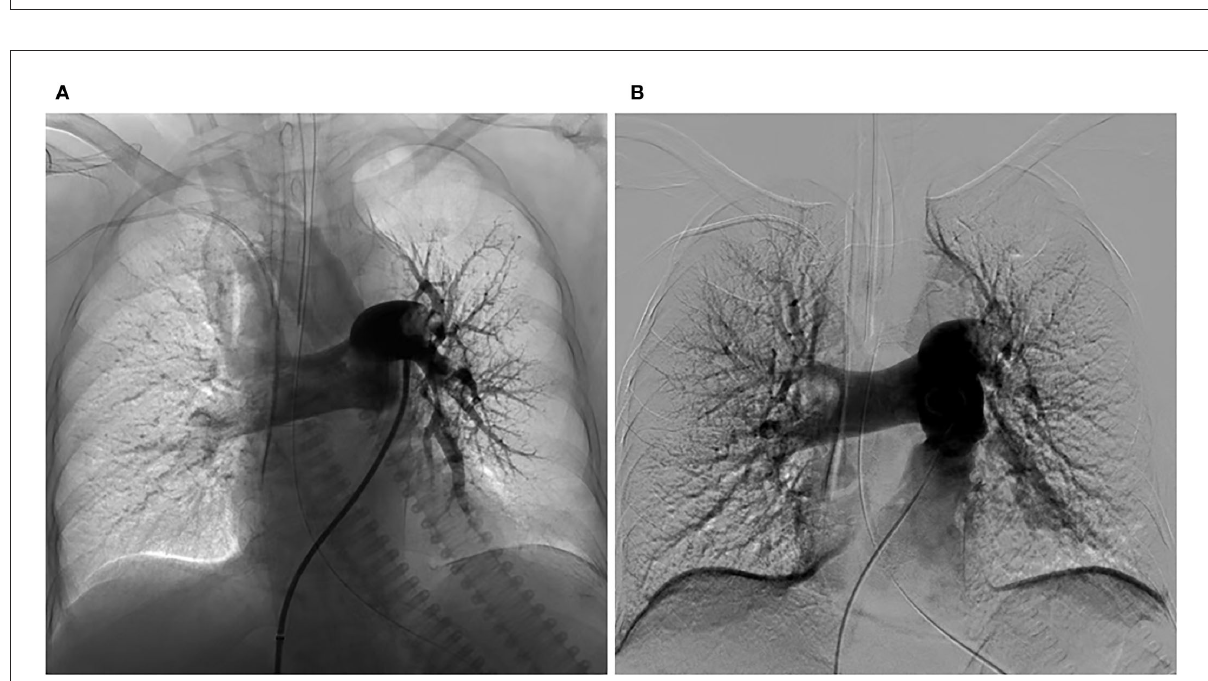
FIGURE2 Changes in the pulmonary arteriography before and after CDT. (A) Pulmonary angiogram showing a mass filling defect in the distal end of bilateral pulmonary artery trunks and branches of the left lower lobes and poor perfusion before CDT. (B) Pulmonary angiogram showing the reduced defect of the thrombus in bilateral pulmonary artery trunks and improved perfusion after CDT. Pulmonary artery pressure before and after were 44/29 mmHg and 45/20 mmHg, respectively.